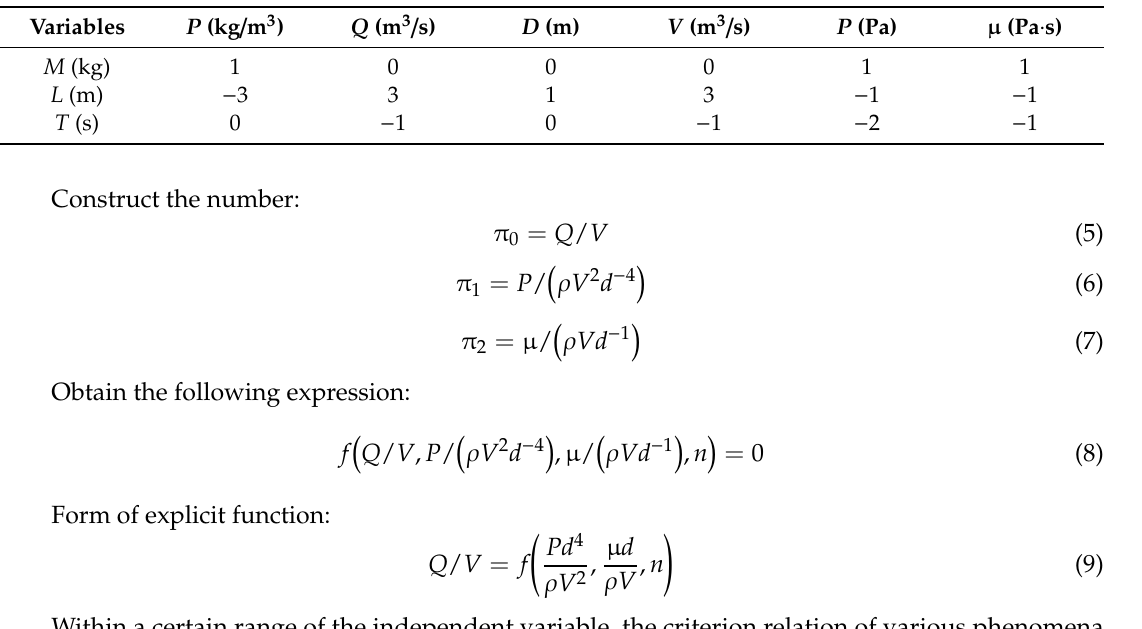
Table 2. Chart of dimension